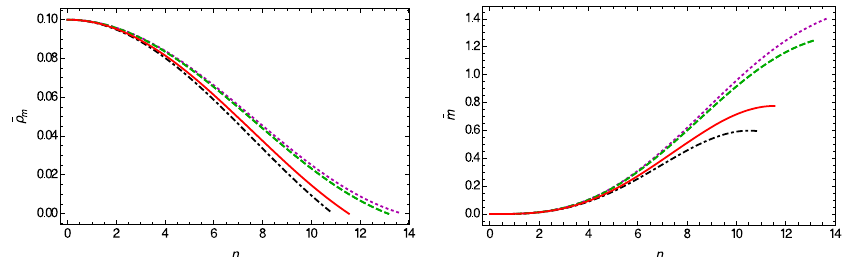
Fig. 22 Variations of the density profiles ¯ ρ m of the superfluid matter (left panel) and of the normalized mass profile ¯ m (right panel) as a function of the radial distance η for the three-form field Bose–Einstein condensate stars, for three different values of the constant ¯ λ : ¯ λ = 0